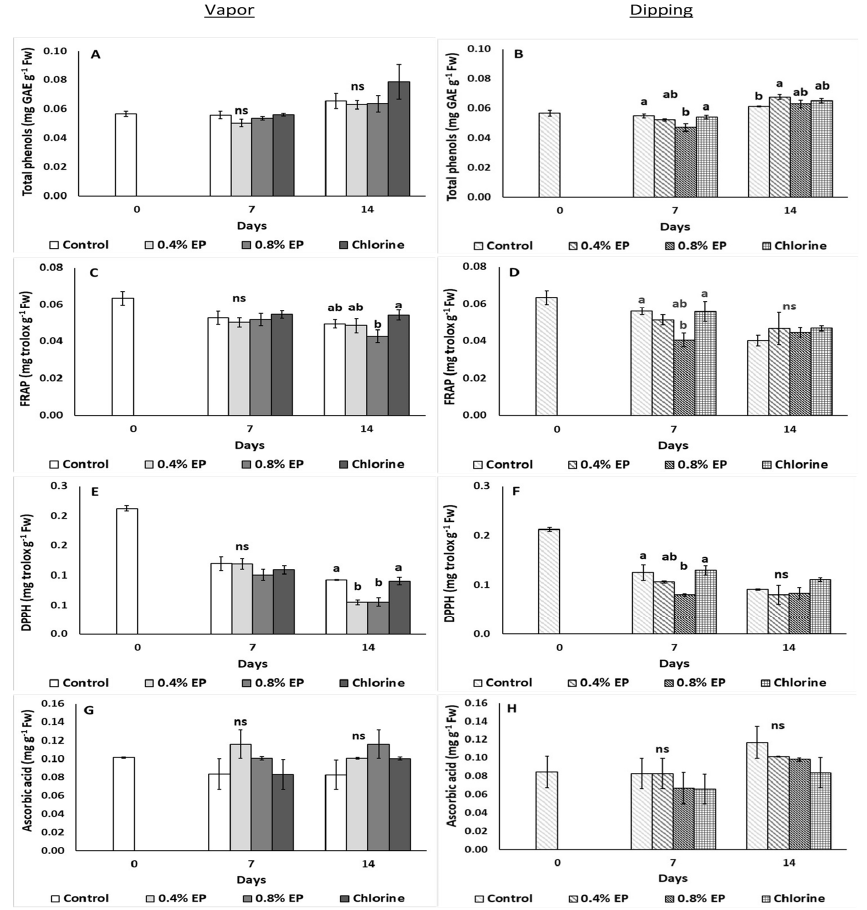
Figure 7. Effects of vapor ( A , C , E , G ) or dipping ( B , D , F , H ) application with eco-product (EP) at different concentration (0–0.4% and 0.8%), chlorine (0.02%) or control (application with water) on total phenols content (mg GAE g − 1 Fw), on ascorbic acid (mg g − 1 Fw), and antioxidant activity (FRAP, DPPH; mg trolox g − 1 Fw) of cucumber fruits stored at 11 °C and RH ~90% up to 14 days. Means ± SE followed by different Latin letters are significantly different according to Duncan’s MRT ( p = 0.05). ns: not significant.